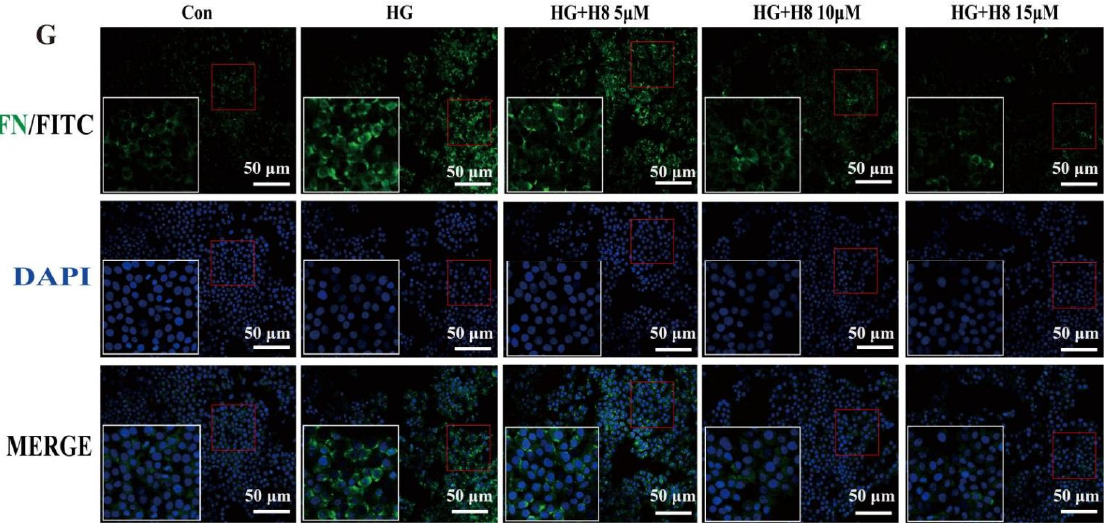
Figure 1. H8 mitigated ECM over-accumulation in HG-stimulated HK-2 cells. ( A ) The H8 chemical structure: (2E, 5E)-2,5-double [(2-fluoro-6-three fluoromethyl) benzyl methylene]-cyclopentone (C 21 H 12 F 8 O; relative molecular mass: 432.31). The effects of different concentrations of H8 on the proliferation of HK-2 cells at the various time points of ( B ) 24 h and ( C ) 48 h. HK-2 cells were co-treated with H8 (5, 10, and 15 μ M) and HG (35 mM) for 48 h. ( D ) The mRNA expression levels were examined by qPCR, and the values were normalized to rps16 ( α -SMA, TGF- β 1, FN, Col IV, and E-Ca). ( E ) Western blot band. ( F ) The protein relative expression levels ( α -SMA, TGF- β 1, FN, Col IV, E-Ca, and the ratio of P-p38MAPK/p38MAPK). ( G ) The IF was performed using FN antibody, and DAPI was used for staining cell nuclei (scale bar = 50 μ m). Data are shown as mean ± S.D. ( n = 5). ## p < 0.01, and ### p < 0.001 compared to Con group; * p < 0.05, ** p < 0.01, and *** p < 0.001 compared to HG group; n.s. represents no significant difference in statistics compared to HG group.